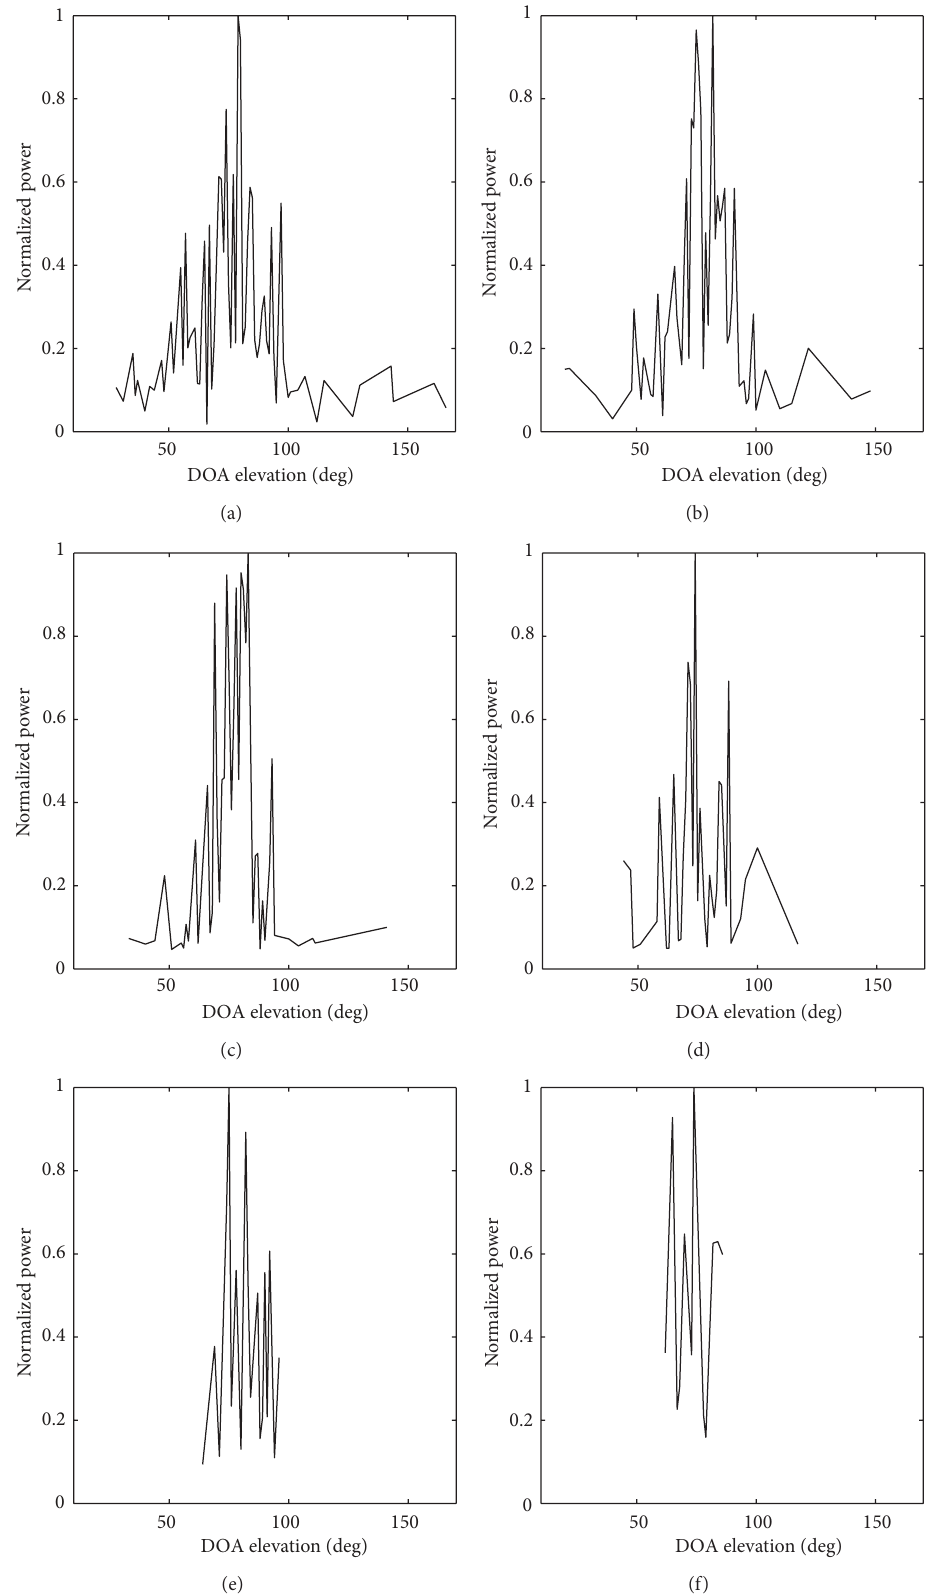
Figure 12: Empirical PAPES at (a) 𝑇 0 , (b) 𝑇 1 , (c) 𝑇 2 , (d) 𝑇 3 , (e) 𝑇 5 , and (f) 𝑇 6